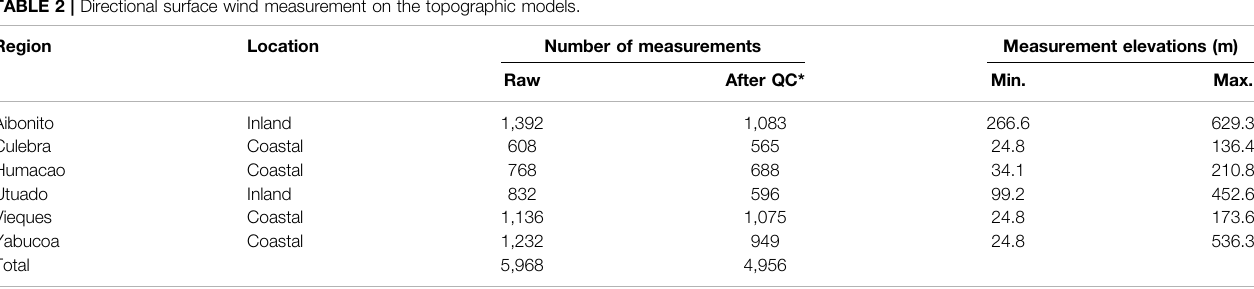
TABLE 2 | Directional surface wind measurement on the topographic models.